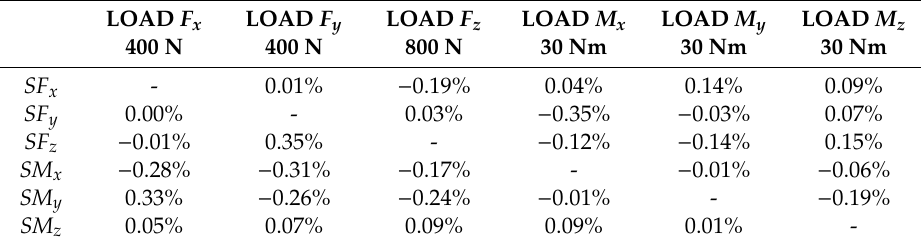
Table 3. Cross-talk readings of the finite element analysis (FEA) results.